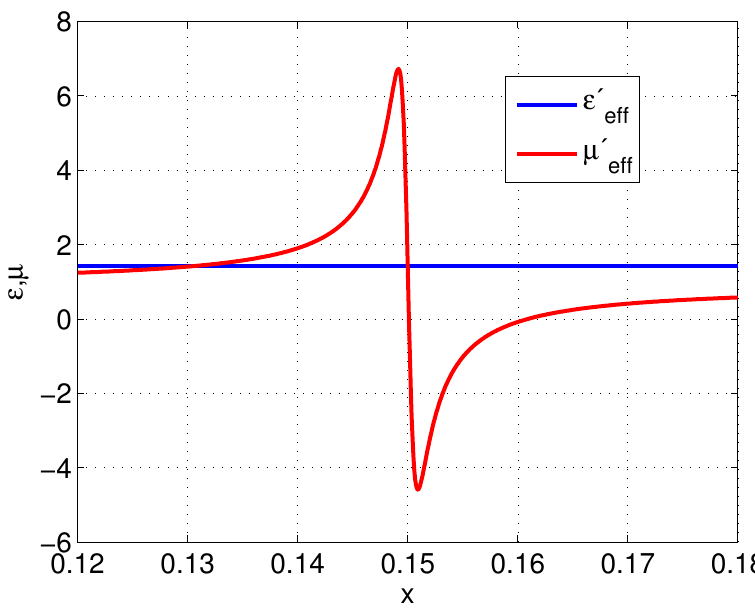
Figure 2. Effective parameters µ (cid:48) of a lattice of all-dielectric RA cylinders with and ε (cid:48) eff eff = 1 , ε = 253 and µ = 1 with area fraction p = 0 . 2 . The lattice exhibits ε ρ ϕ z